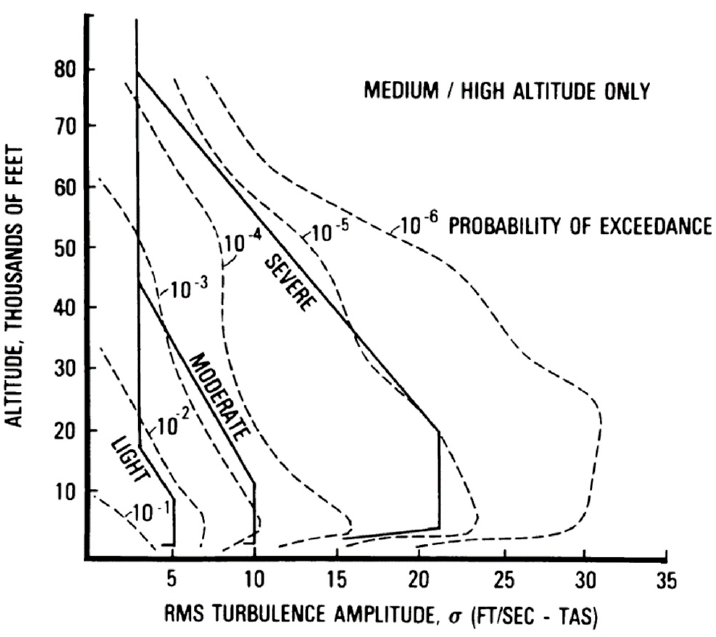
Figure 35. Probability distribution of turbulence intensities [29].